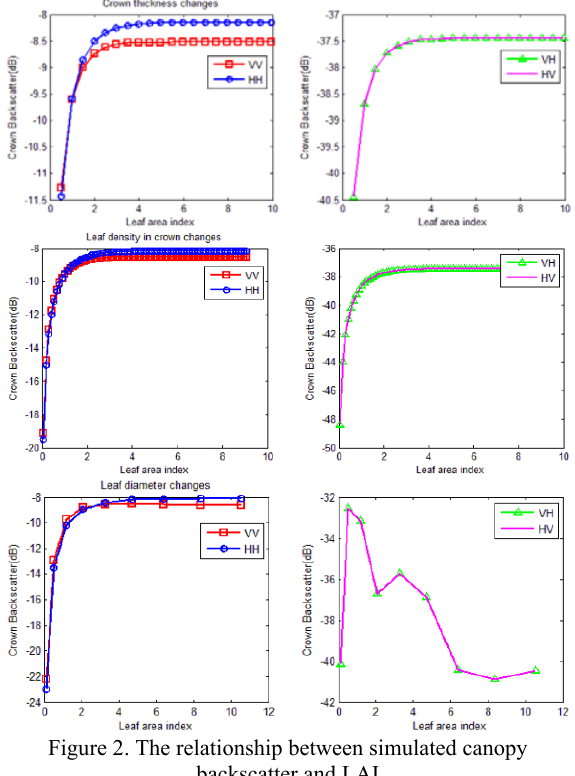
Figure 2. The relationship between simulated canopy backscatter and LAI The factors influencing microwave backscatters are complicated. The simulations will differ from different vegetation structure parameters, incident angles and